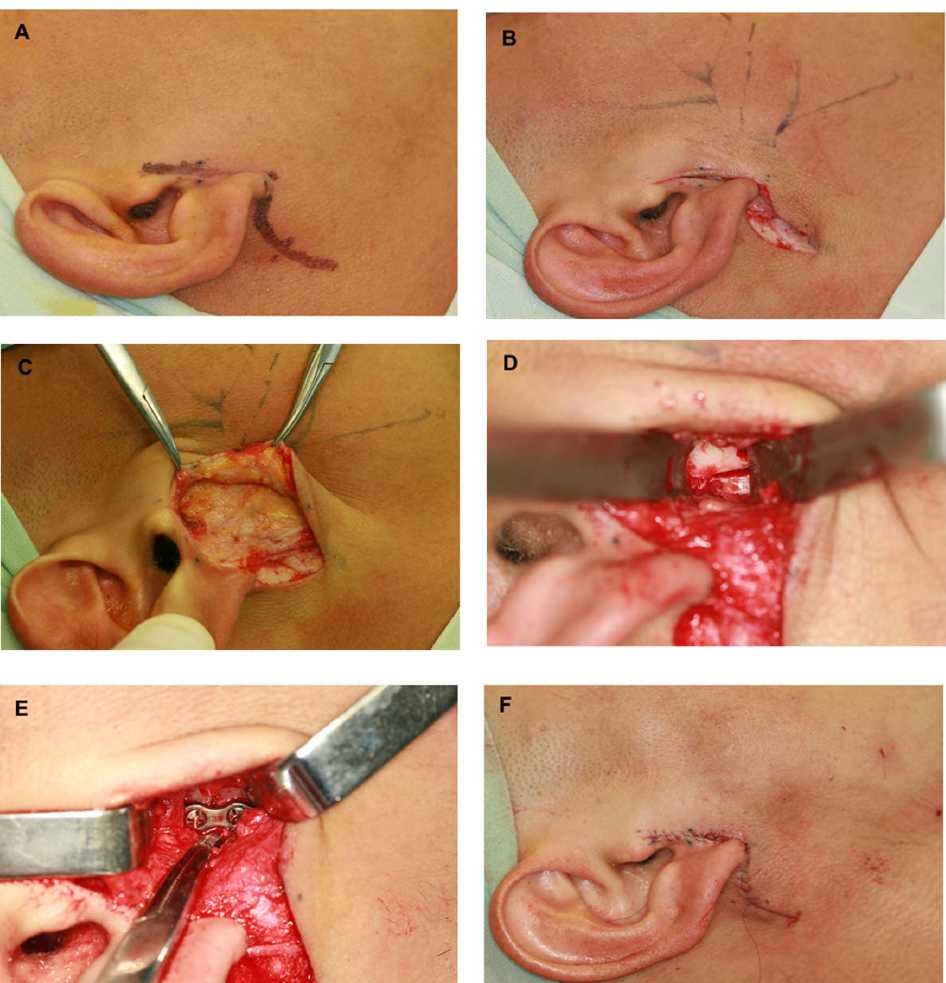
Figure 1. Photographs show a 25-year-old male patient undergoing open reduction and rigid internal fixation of right condylar fracture under general anaesthesia. A: Design; B: Incision; C: Flap elevation and exposure of the SMAS fascia; D: Exposure of condylar fracture; E: Rigid internal fixation; F: Suture.